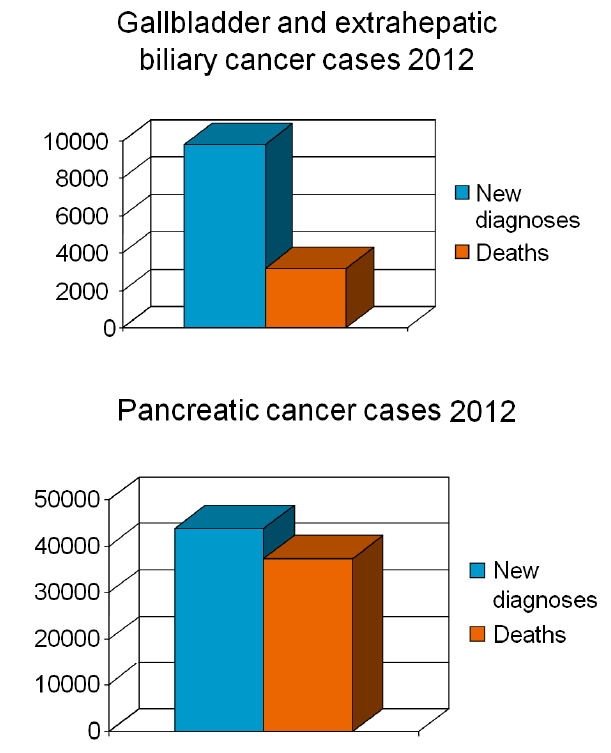
Figure 1. Number of expected new cases and deaths of pancreatic cancer and gallbladder and extrahepatic biliary cancer in the United States in 2012 1